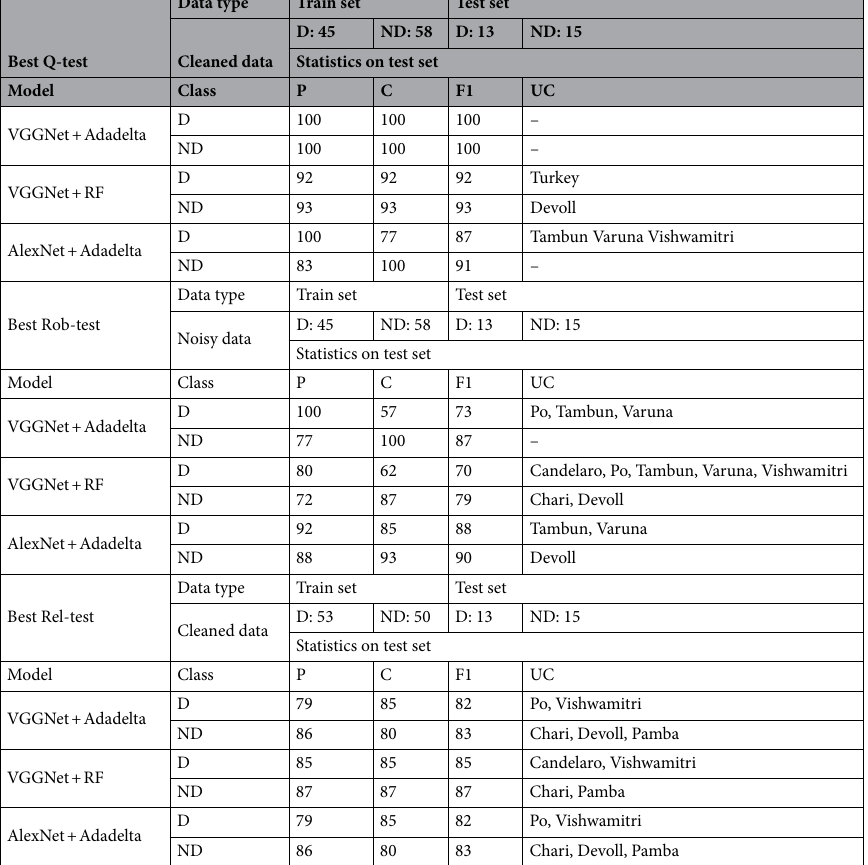
Table 1. Statistical results of the three kinds of classification experiments, performed on the set of 131 drainage networks. P purity, C completeness, and F1 F1-score, are in percent. UC reports the list of mismatched samples. D dendritic, ND non-dendritic